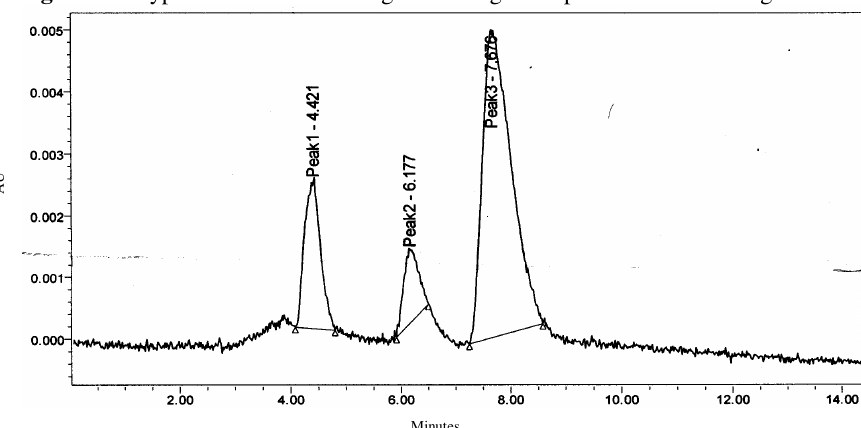
Figure 5b. Typical HPLC chromatogram of degraded product at wave length 254 nm